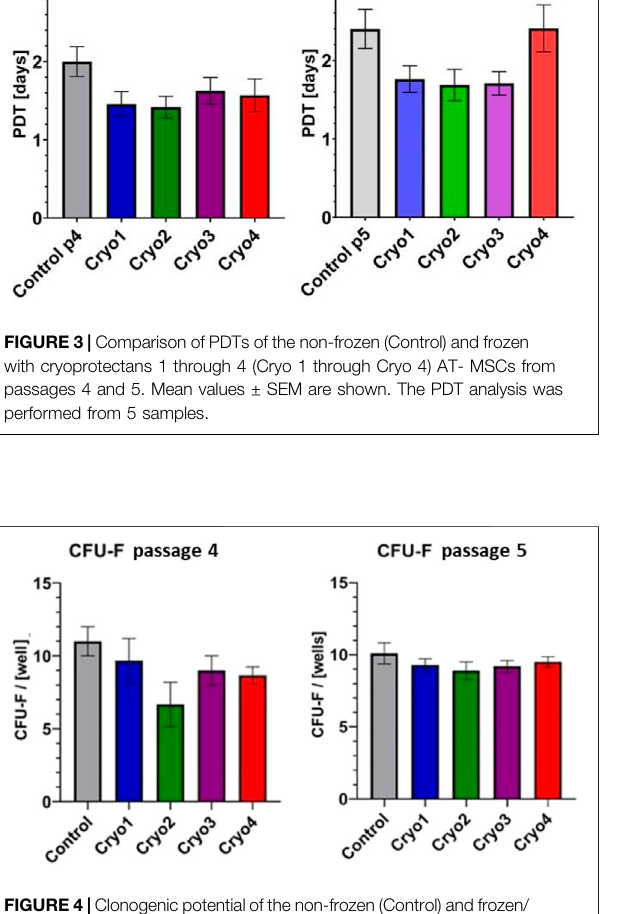
FIGURE 4 | Clonogenic potential of the non-frozen (Control) and frozen/ thawed (Cryo 1 through Cryo 4) AT-MSCs obtained from passages 4 and 5. Mean values ± SEM are shown. The CFU-F analysis was performed from 5